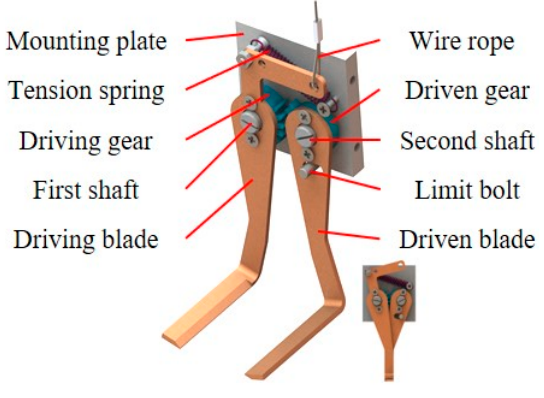
Figure 9. Shearing Figure 9. Shearing mechanism.